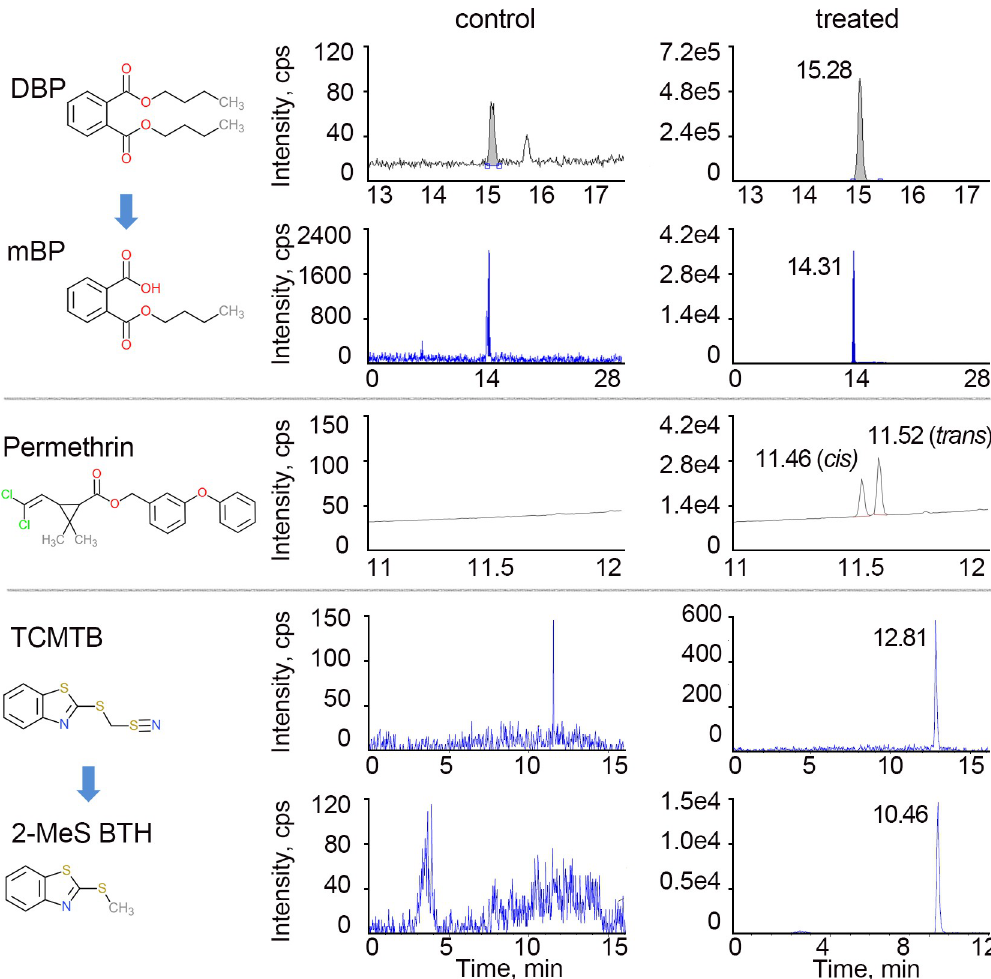
Fig 7. Structures and representative LC-MS/MS and GC-MS chromatograms for DBP, permethrin, TCMTB and their metabolites. Chromatograms on the left show results from the analysis of the indicated chemicals and metabolites in worms exposed to vehicle alone (DMSO; control) and chromatograms on the right show results from worms exposed to DBP, permethrin, and TCMTB (treated). These chemicals were unambiguously identified and quantified using their respective internal standards. Y-axis represents relative abundance of signal intensity and X-axis represents retention time in minutes. The detected concentrations following chemical treatments (right) were consistently greater than in control (note differences in Y-axis). Note that the peak at 12.81 minutes does not correspond to TCMTB (expected peak for TCMTB is at 8.76), suggesting that TCMTB is very rapidly metabolized in the